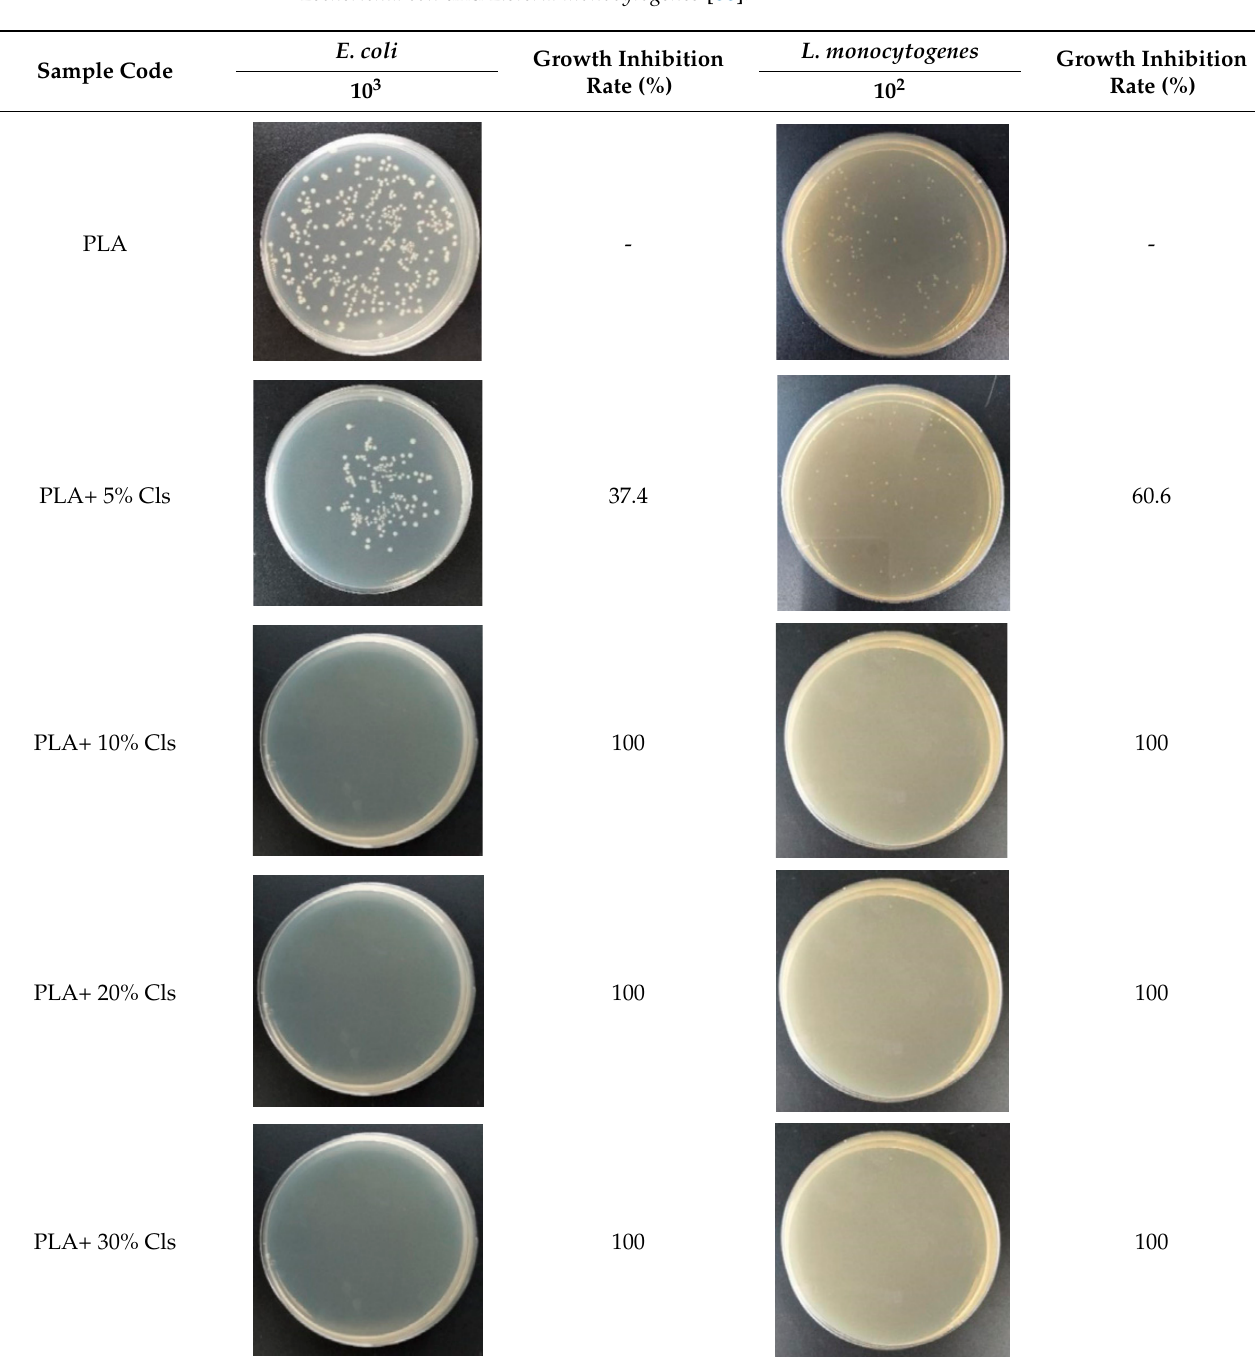
Table 8. Antibacterial effect of PLA antibacterial films with 0, 5, 10, 20, and 30% of CIs on Escherichia coli and Listeria monocytogenes [66] .